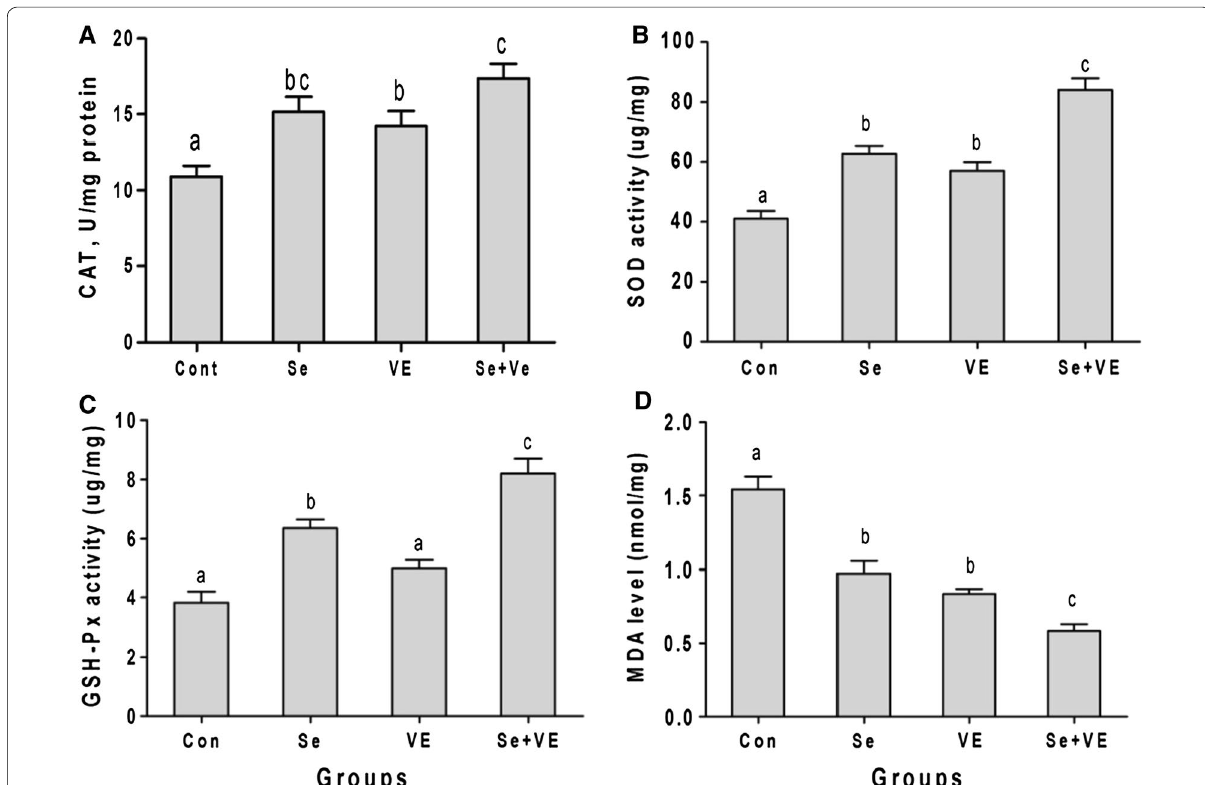
Fig. 2 Effect of Se, VE and Se VE on antioxidant activity A CAT, B SOD, C GSH‑Px, and D MDA in breast muscles of heat stressed broiler chickens. + Mean values with their standard errors. The values with unlike superscript letters (a, b, c) in the graph are different (P <